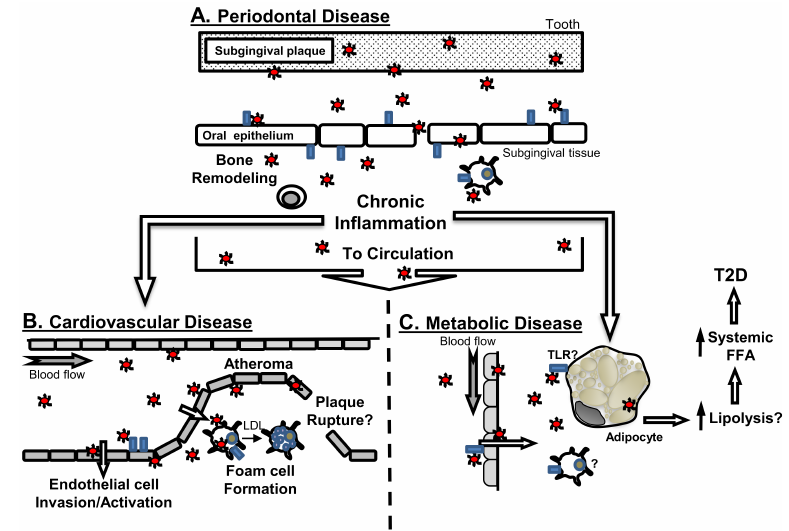
Figure 1. Connections of periodontal disease to systemic diseases and implication of